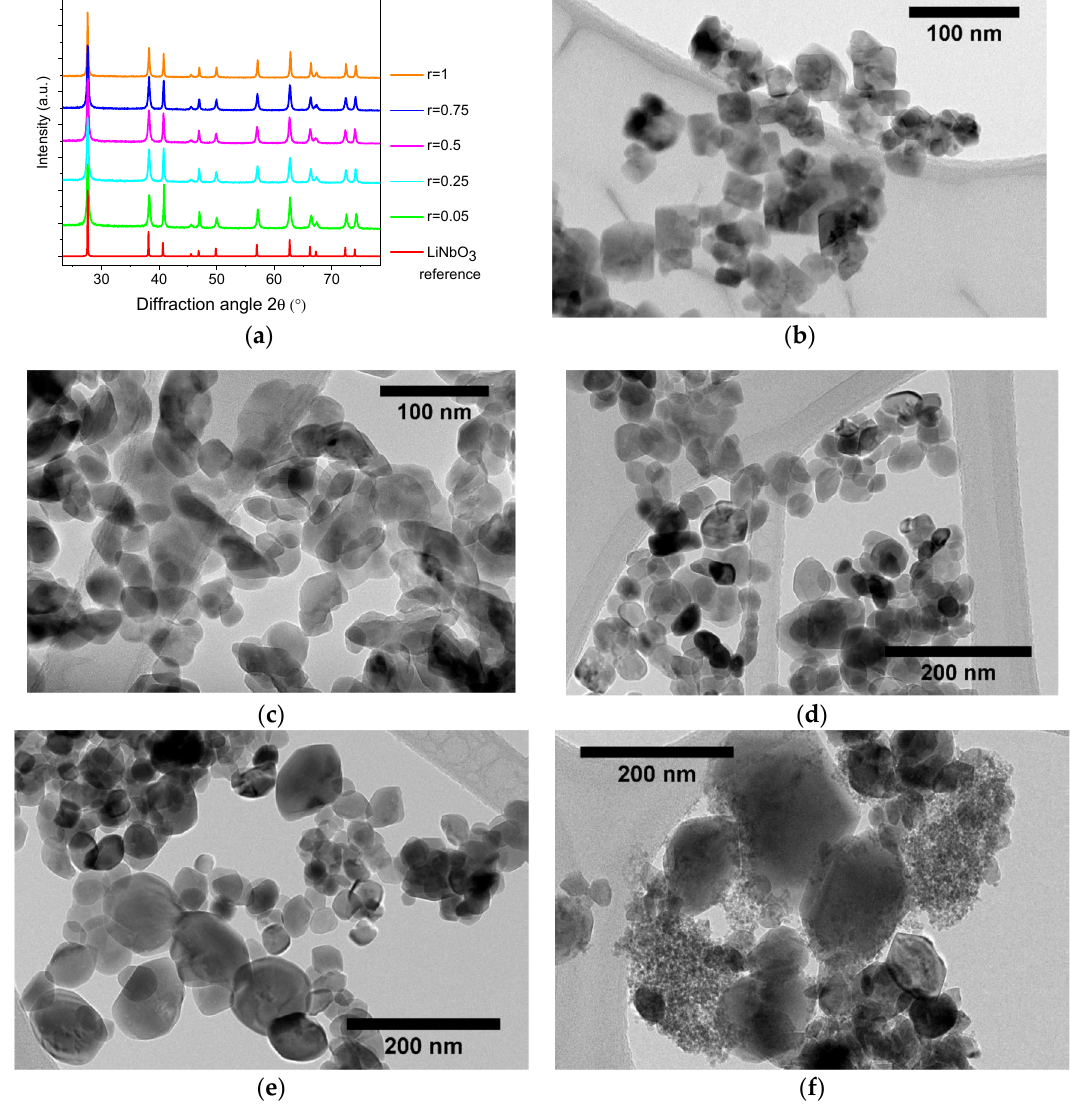
Figure 2. ( a ) XRD diffraction patterns of LN nanocrystals for increasing values of the molar ratio r of 1,4-butanediol to ethanol. Corresponding TEM images for ( b ) r = 0.05, ( c ) r = 0.25, ( d ) r = 0.5, ( e ) r = 0.75, and ( f ) r = 1.